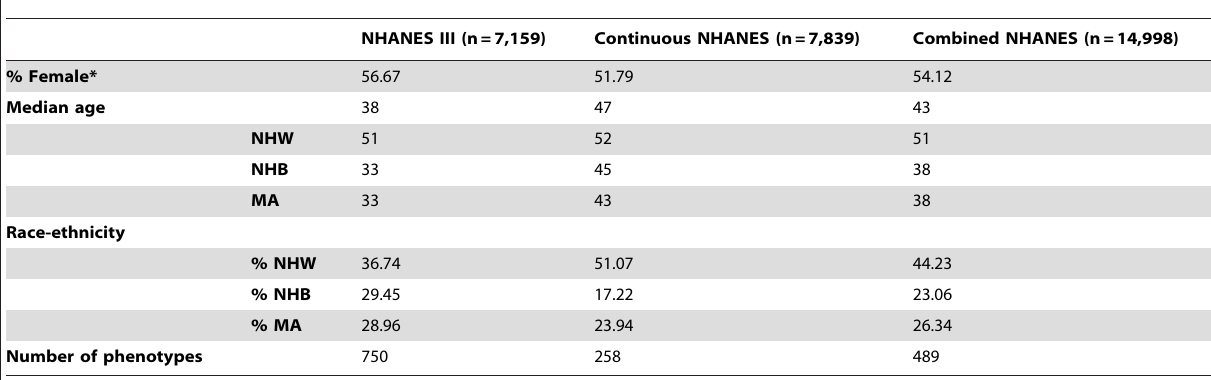
Table 1. Study population characteristics.